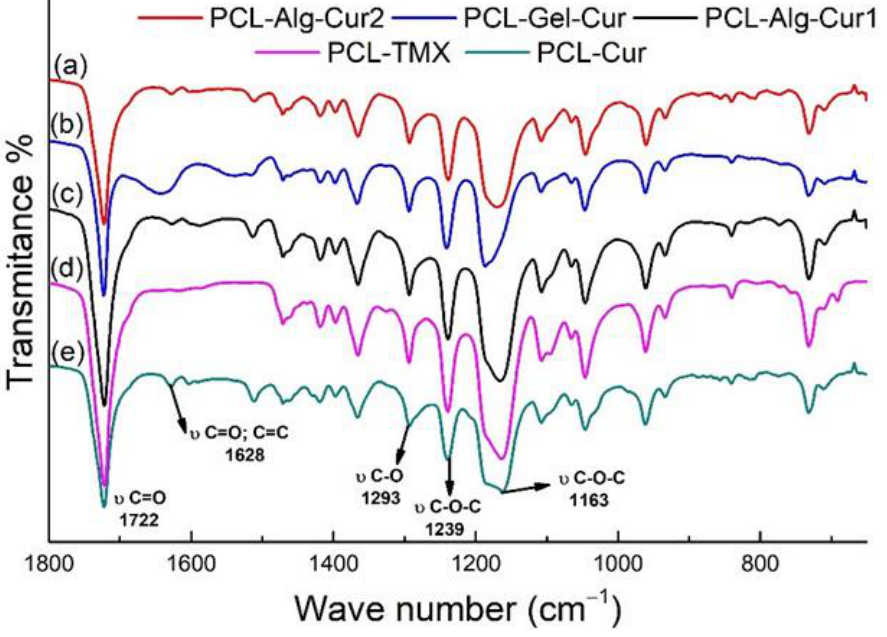
Figure 3. FTIR spectra of the nanofibers manufactured. ( a ) PCL–Alg–Cur2 ( b ) PCL–Gel–Cur ( c ) PCL–Alg–Cur1 ( d ) PCL–TMX and ( e ) PCL–Cur.